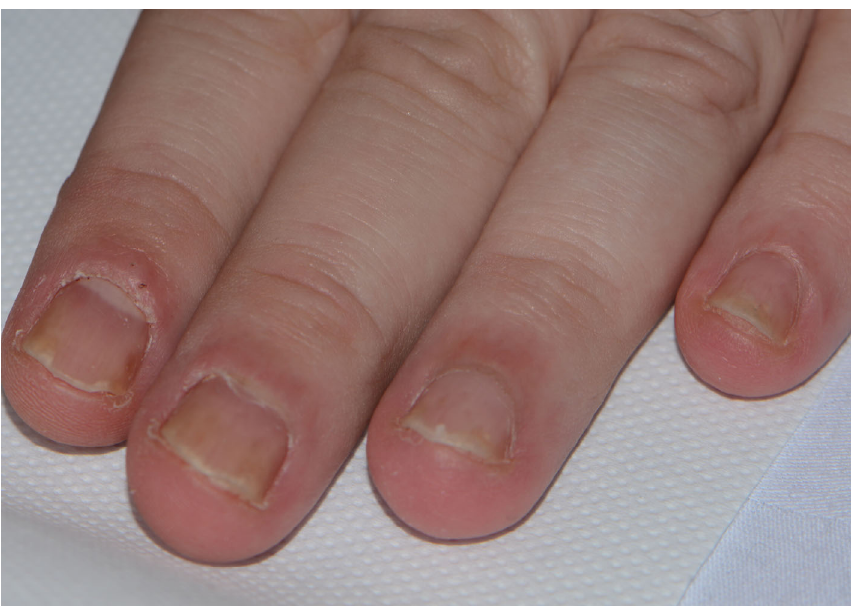
Figure 3. Psoriatic nail dystrophy.